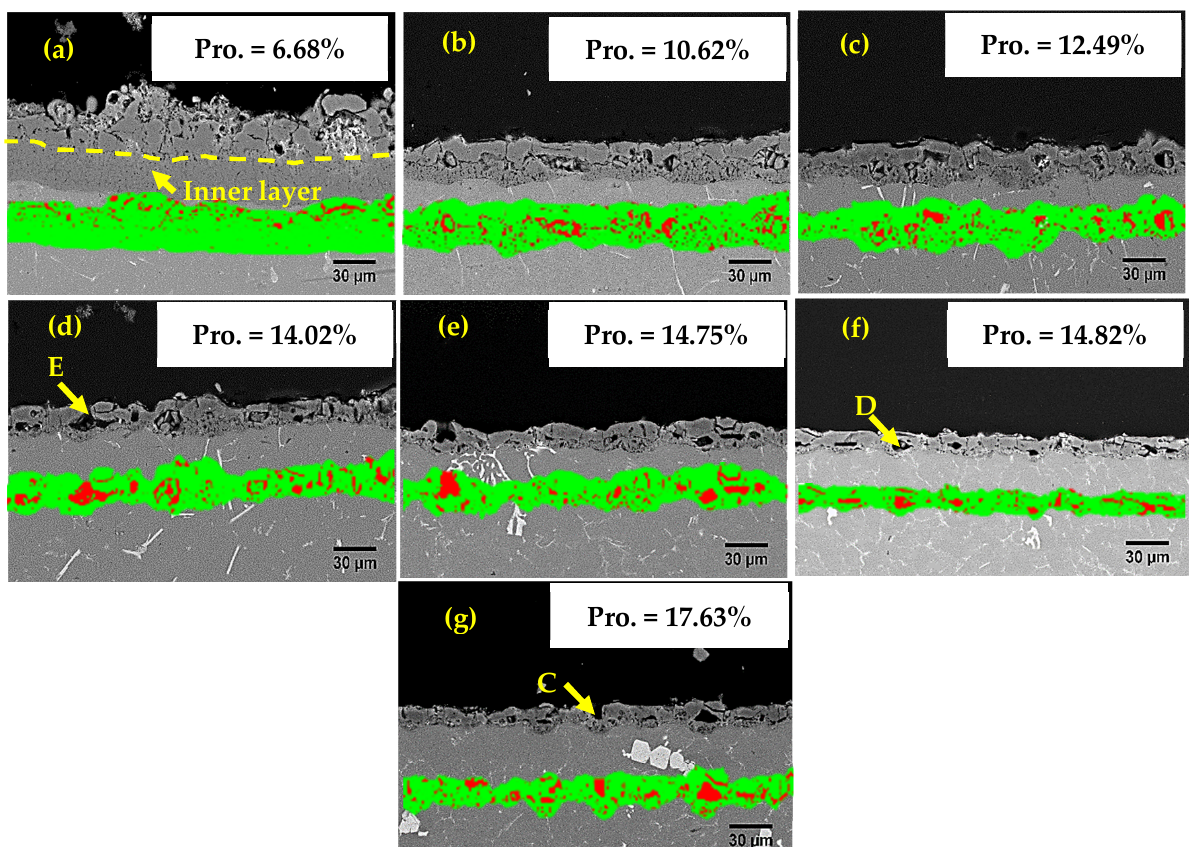
Figure 8. SEM images of cross-sections of the PEO-coated sample in the silicate-based Na 2 WO 4 additive electrolyte on different Al–Si alloys: ( a ) S1W, ( b ) S3W, ( c ) S5W, ( d ) S7W, ( e ) S9W, ( f ) S11W, and ( g ) S13W. The images appended under each cross-sectional image show the porosity percent view obtained from MIP software.